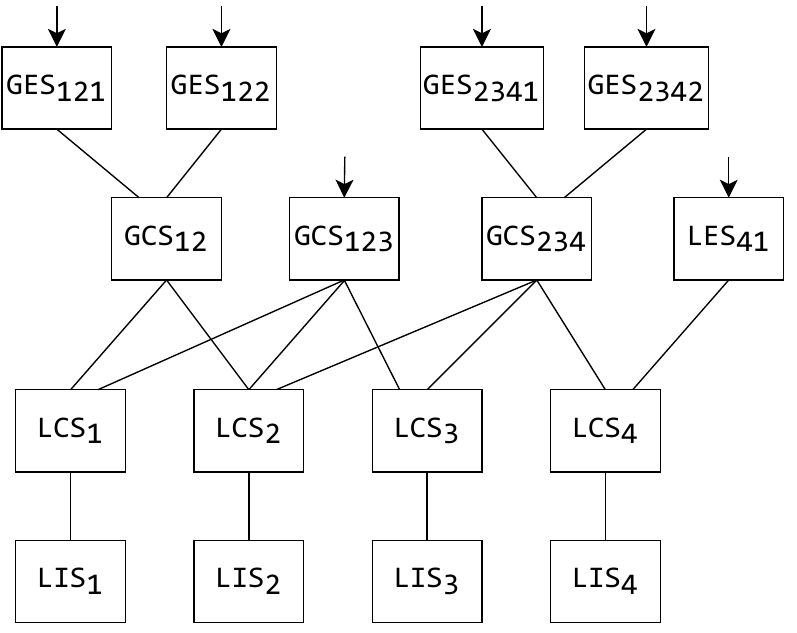
Figure 4. An example of a system-wide schema